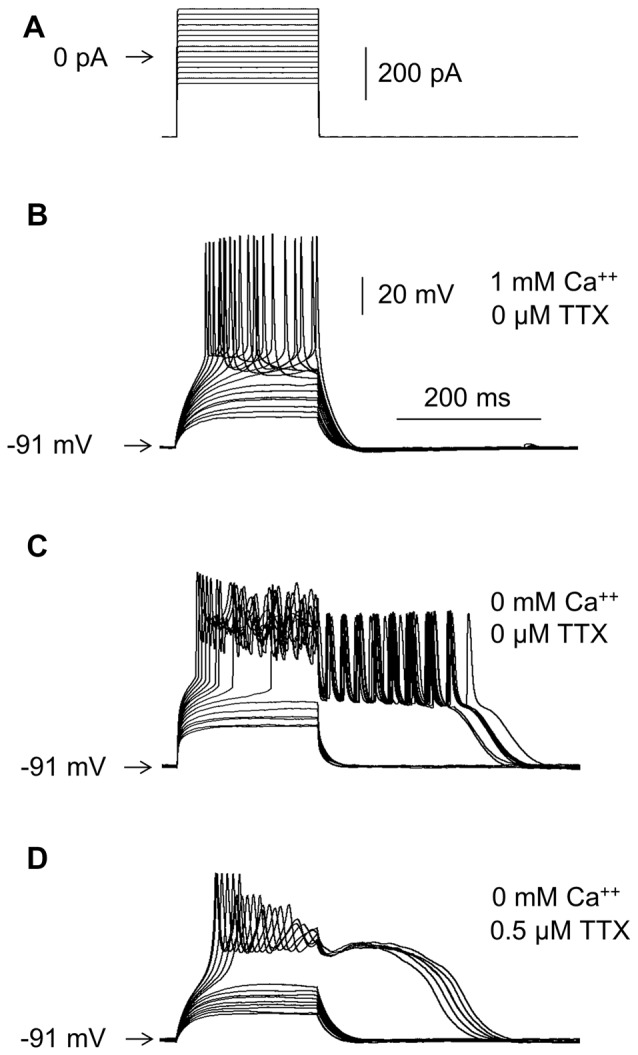
Effects of Ca++ and TTX in the extracellular solution on RD. (A) Portion of the current protocol applied to evoke RD shown in (B–D). Current pulses were preceded by a −300-pA hyperpolarizing current prepulse lasting 1000 ms, followed by a −300-pA current postpulse lasting 1300 ms. Membrane potential changes evoked in the presence of 1 mM of Ca++ and the absence of TTX (B), in the absence of Ca++ and the absence of TTX (C), and in the absence of Ca++ and the presence of TTX (0.5 μM) (D) in the extracellular solution.